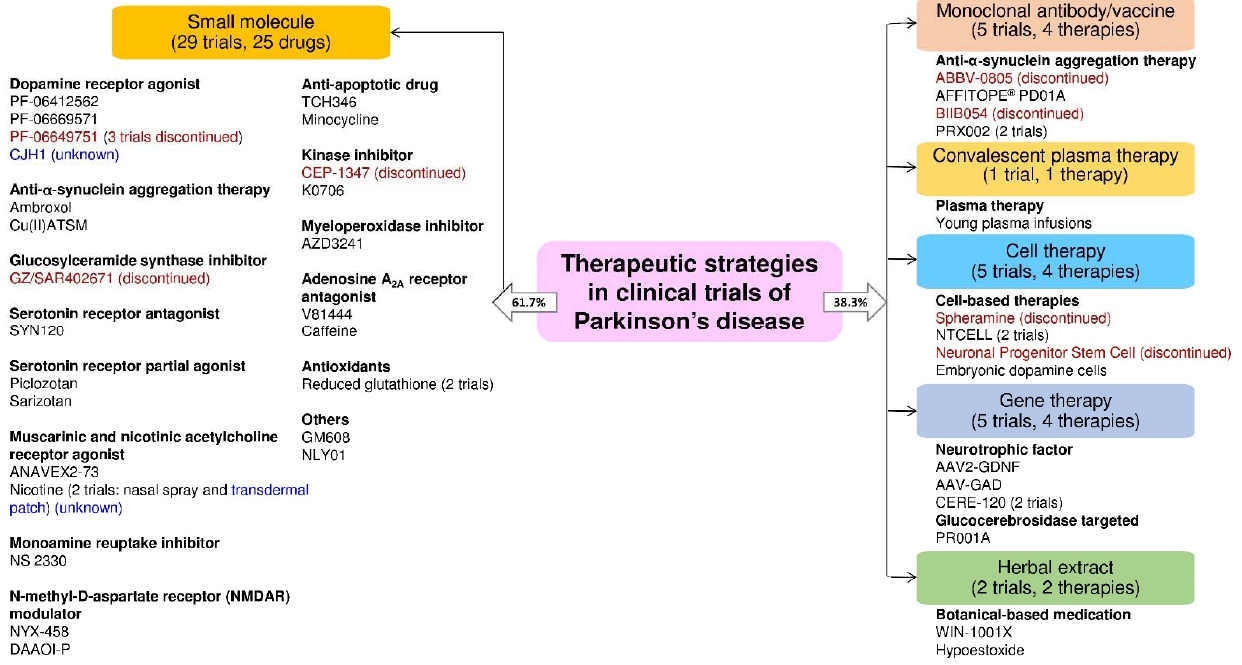
Figure 5. The drug or therapy with its therapeutic strategy and trial status in the clinical trials for PD treatment. The blue and red text color indicates the trial status is unknown and discontinued, respectively (active as of 16 June 2021).